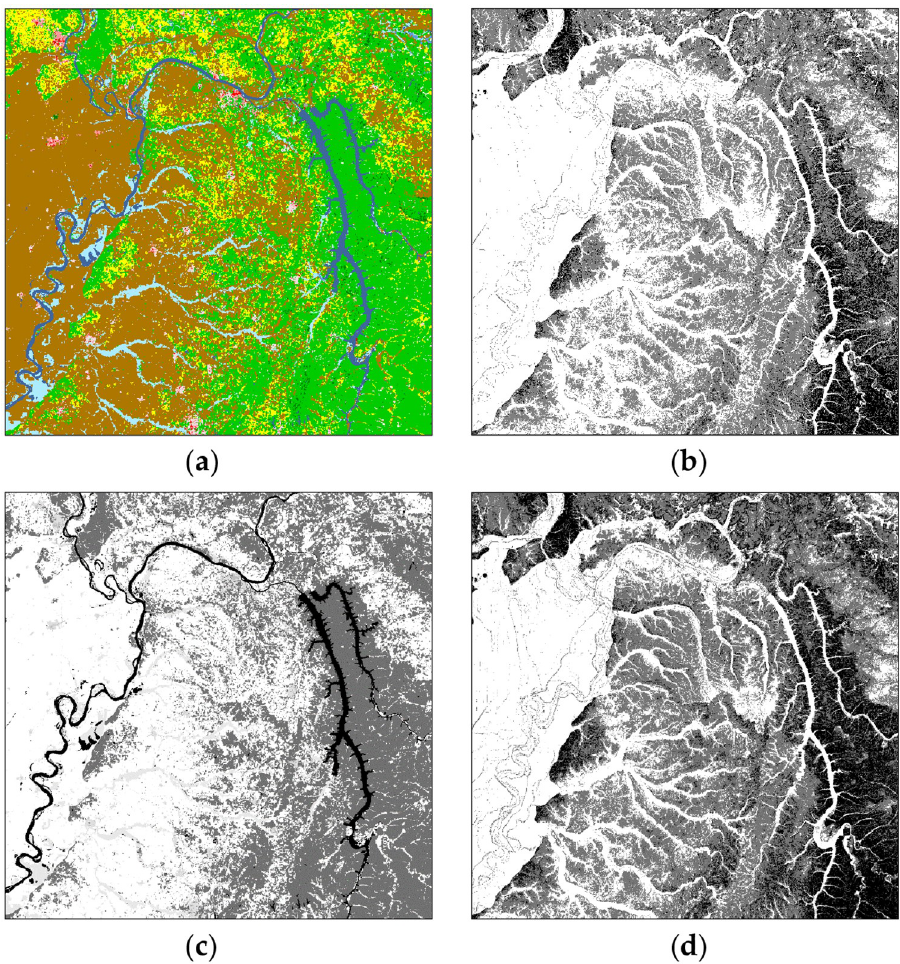
Fig 3. 1000 × 1000 EISPC raster data (a) land cover (b) slope (c) environmental impact (d) economic cost. In (b) light color is less slope and dark color is more slope, and in (c) and (d) dark color is high cost and light color is low